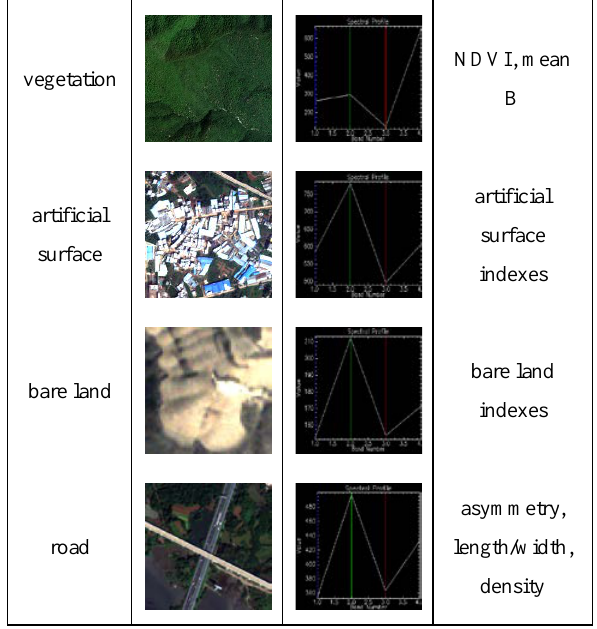
Figure 1. R, G, B layer stacking images and spectral profile of land cover on each band It shows that water exhibits strong reflex and strong absorbing characters respectively in bands of blue and near-infrared, vegetation exhibits the same characters respectively in the bands of red and near-infrared, artificial surface exhibits the same characters respectively in the bands of blue and red-edge, bare land exhibits the same characters respectively in the bands of red and red-edge, and road exhibits the same characters respectively in the bands of blue and near-infrared. These characters would play an important role in the indexes building and automatic